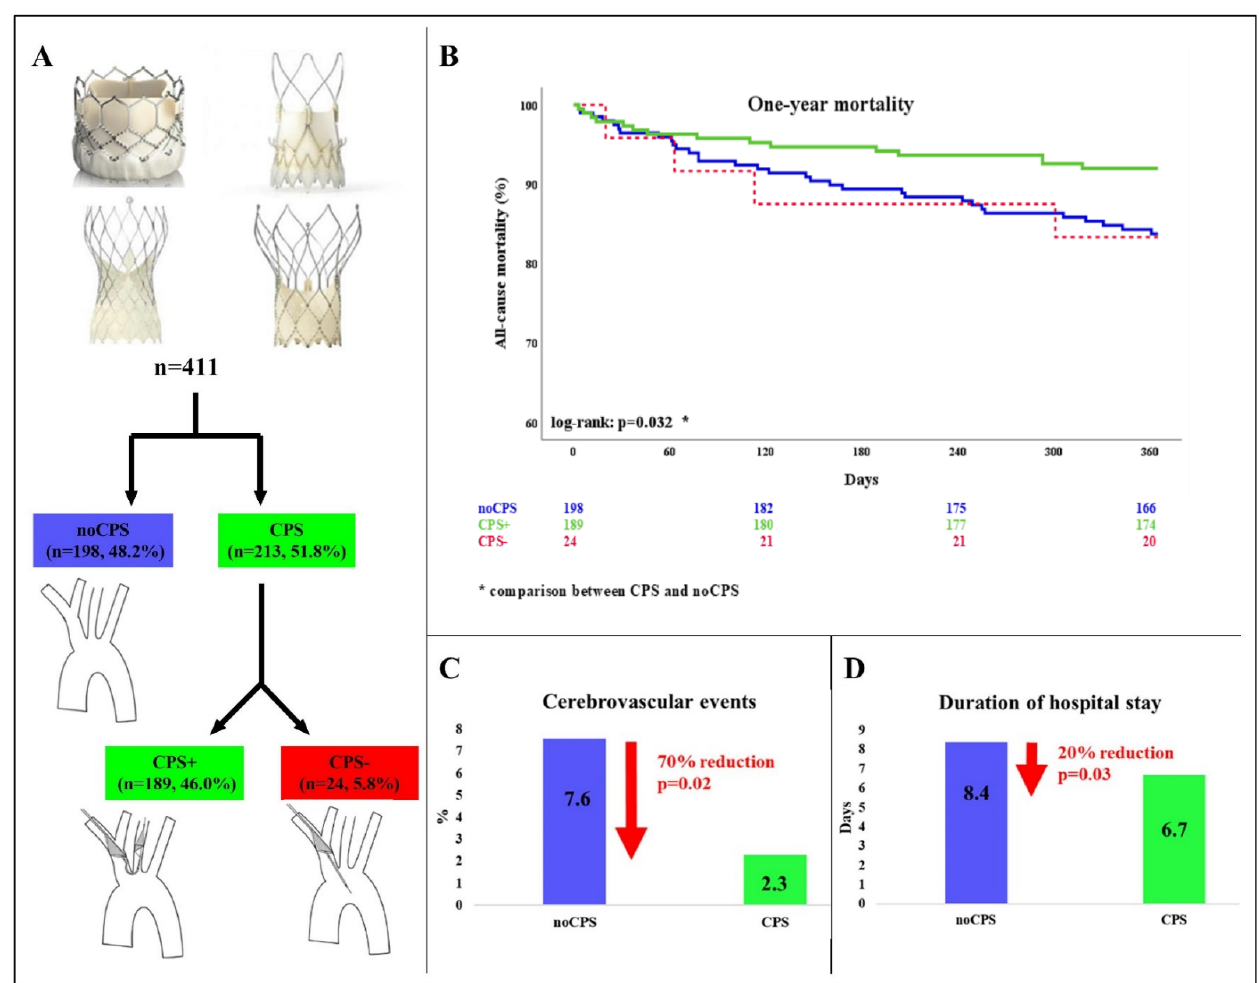
Figure 1. Patient flow. NoCPS indicates TAVR without Sentinel  , CPS indicates TAVR with Senti- nel  . Patients in whom both filters were correctly deployed are presented as CPS+, patients with incomplete/incorrect CPS deployment are indicated as CPS−.